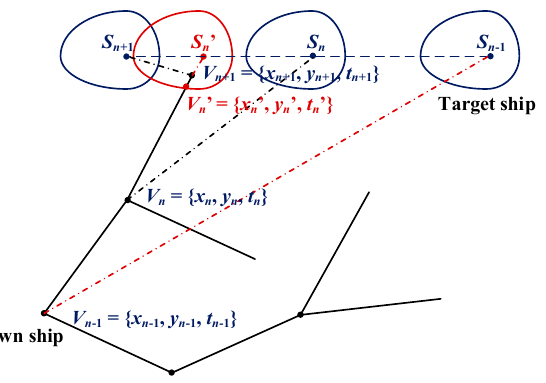
Figure 6. The illustrative demonstration of dynamic collision risk